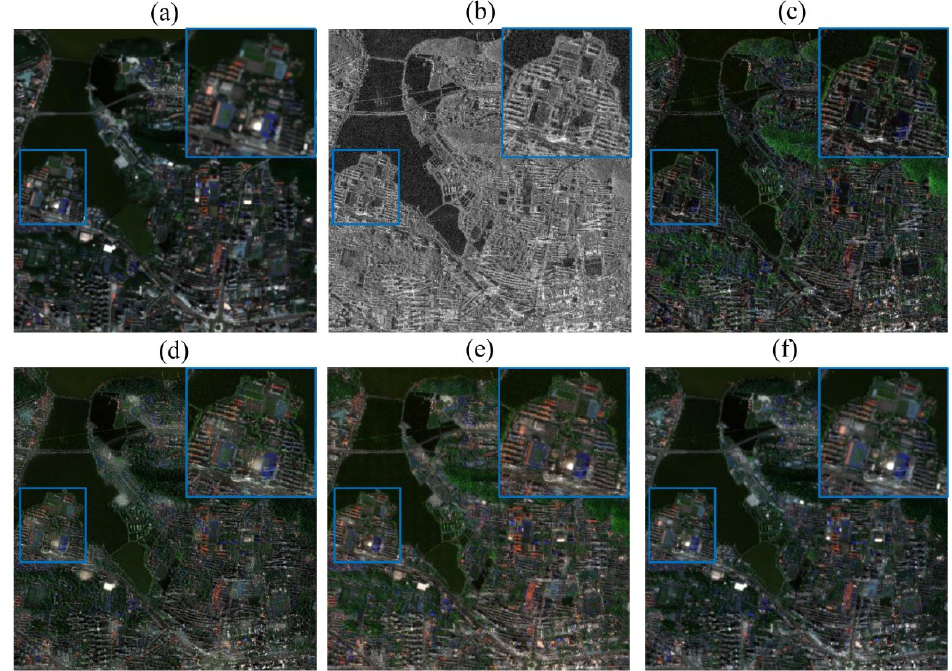
Figure 4. The source images and the fused images with different methods for Site 2: ( a – f ) Sentinel-2A image, TerraSAR image, and the fusion results of IHS, GTF, DWT, and IHS-GTF, respectively.